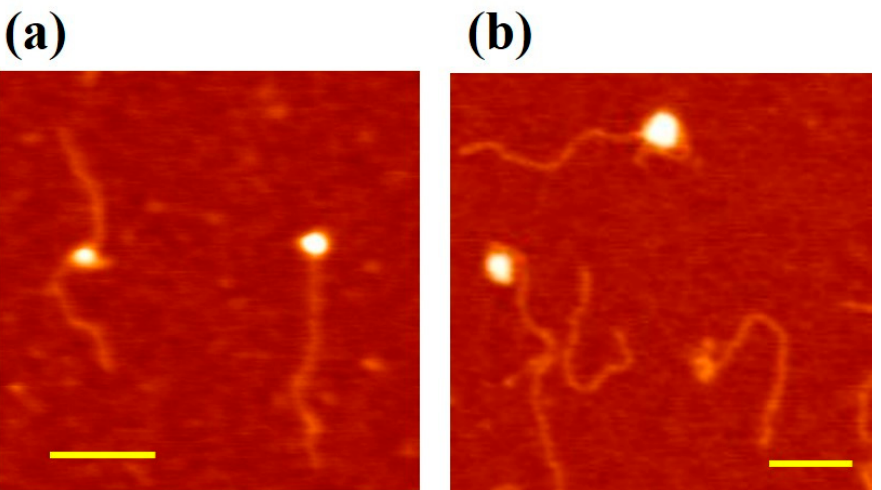
Figure 4. Interaction of MCM mutants with DNA. Here we increased the relative ratio protein/DNA to 10:1 (2 nM 807 bp DNA fragments and 20 nM protein complex). Scale bar 100 nm. ( a ) ∆ sA–DNA complex–DNA interaction. The ∆ sA complex lacks the N-terminal subdomain A, which has been proposed to be involved in wrapping. From the images, we observed that the protein is preferably bound to the end of the DNA fragment; ( b ) NBH–DNA complex–DNA interaction. The NBH mutant has two mutations in the N-terminal β -hairpins, projecting into the centre of the ring, thus affecting the interaction between DNA and the central channel.